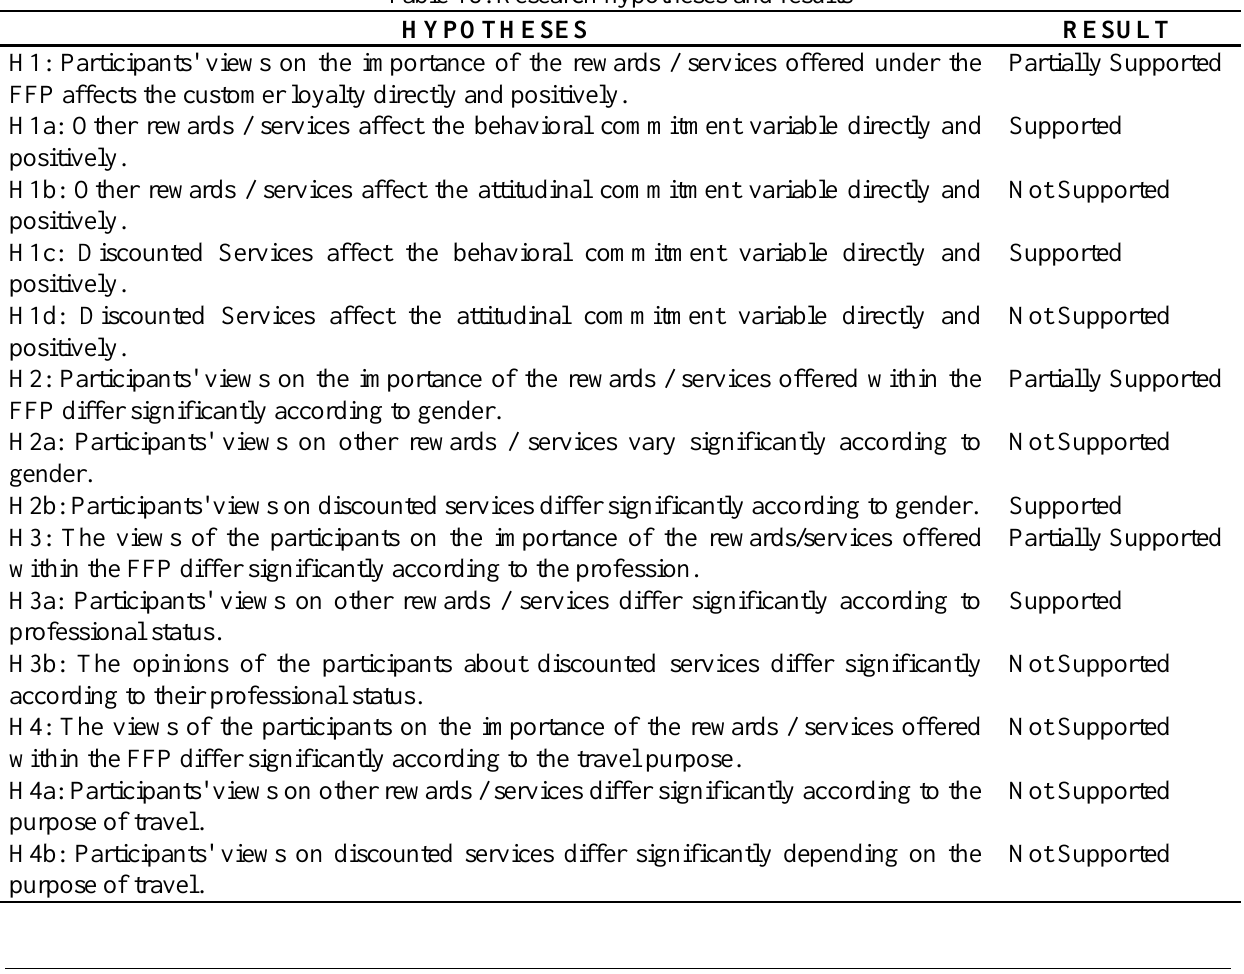
Table 18. Research hypotheses and